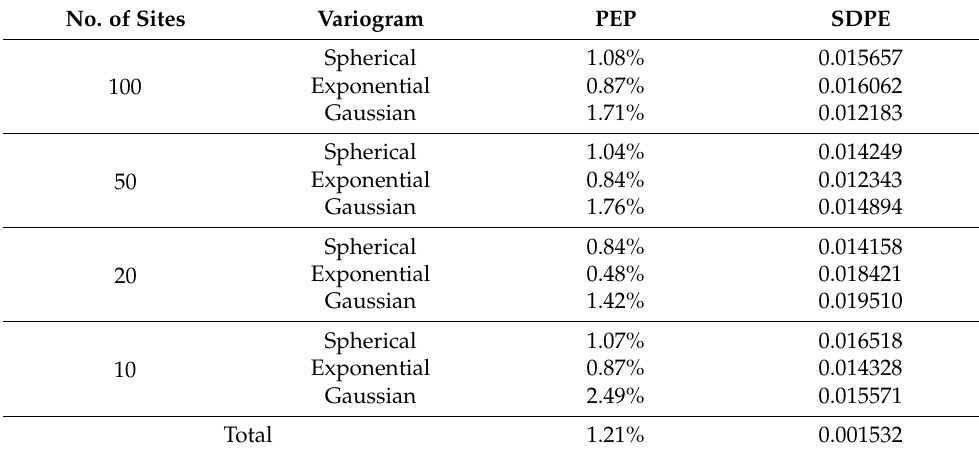
Table 4. Evaluation of prediction results of WEEE Kriging model for